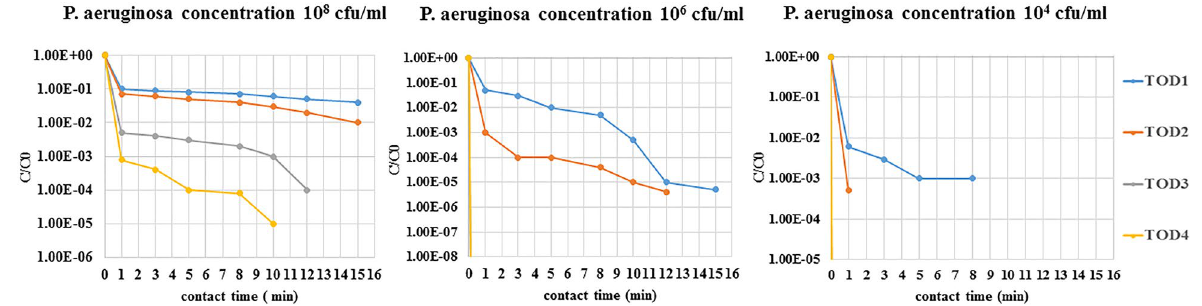
Figure 3. Removal efficiencies of antibiotic-resistant Pseudomonas aeruginosa by ozonation at ozone doses of 11–45 mg/l (TOD1 = 11 mg/l, TOD2 = 25 mg/l, TOD3 = 37 mg/l, TOD4 = 45 mg/l).